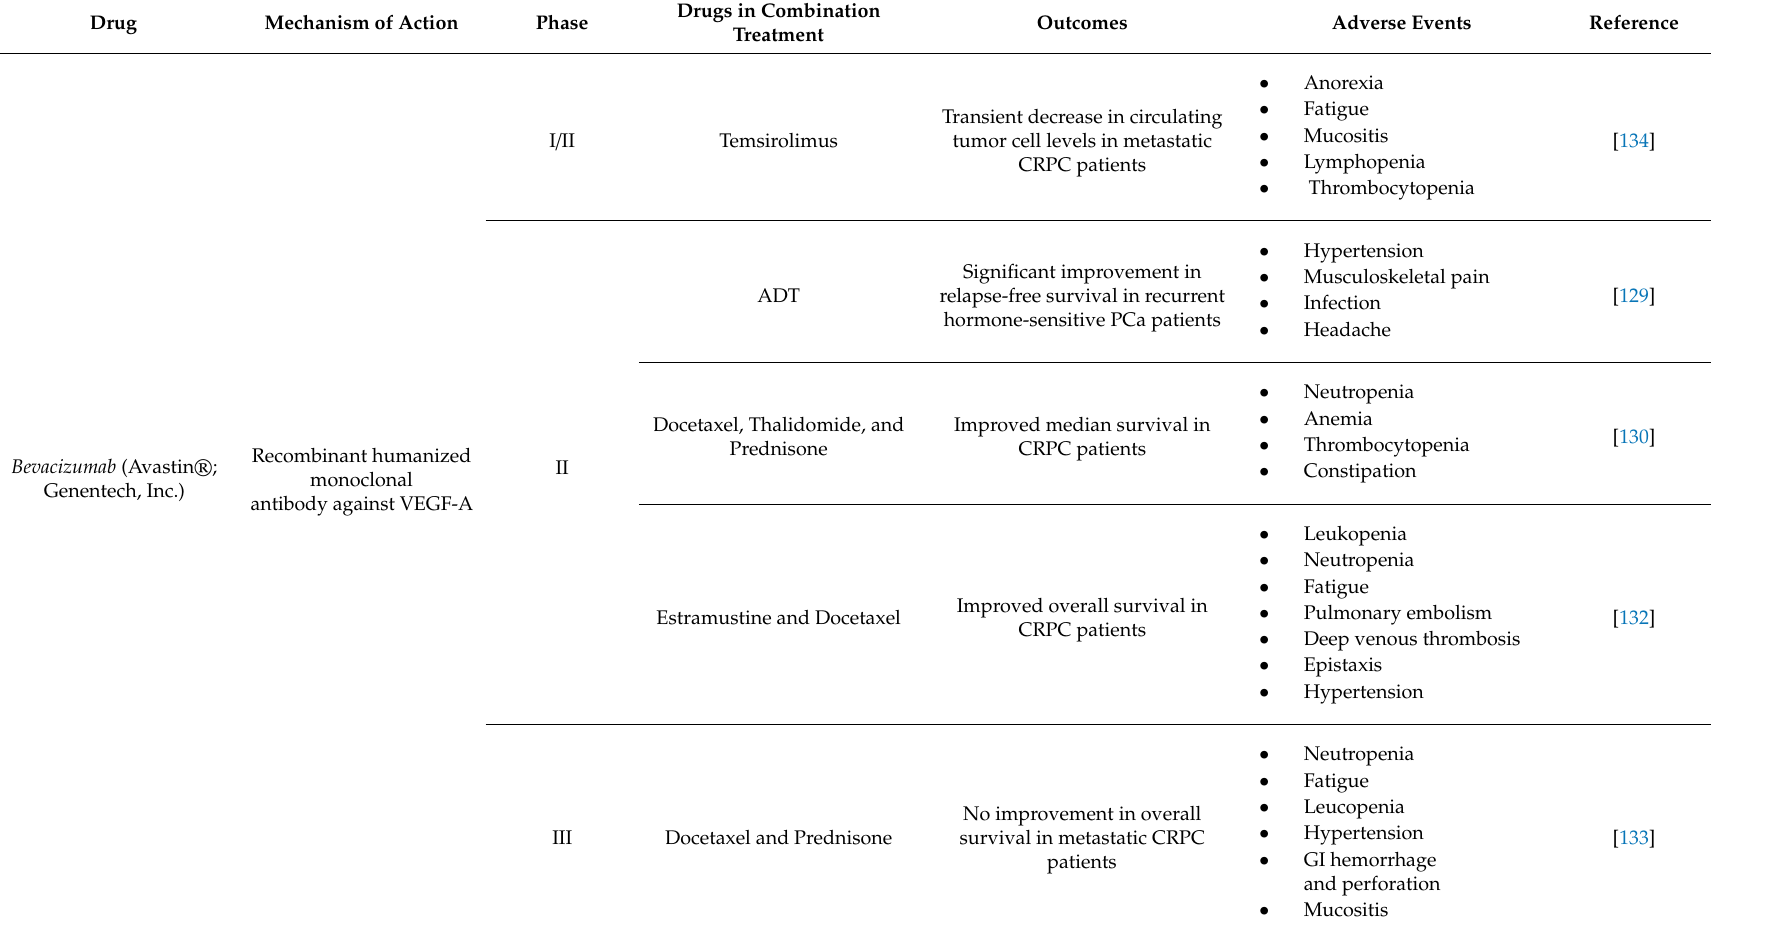
Table 1. Summary of clinical studies of antiangiogenic drugs in the treatment of prostate